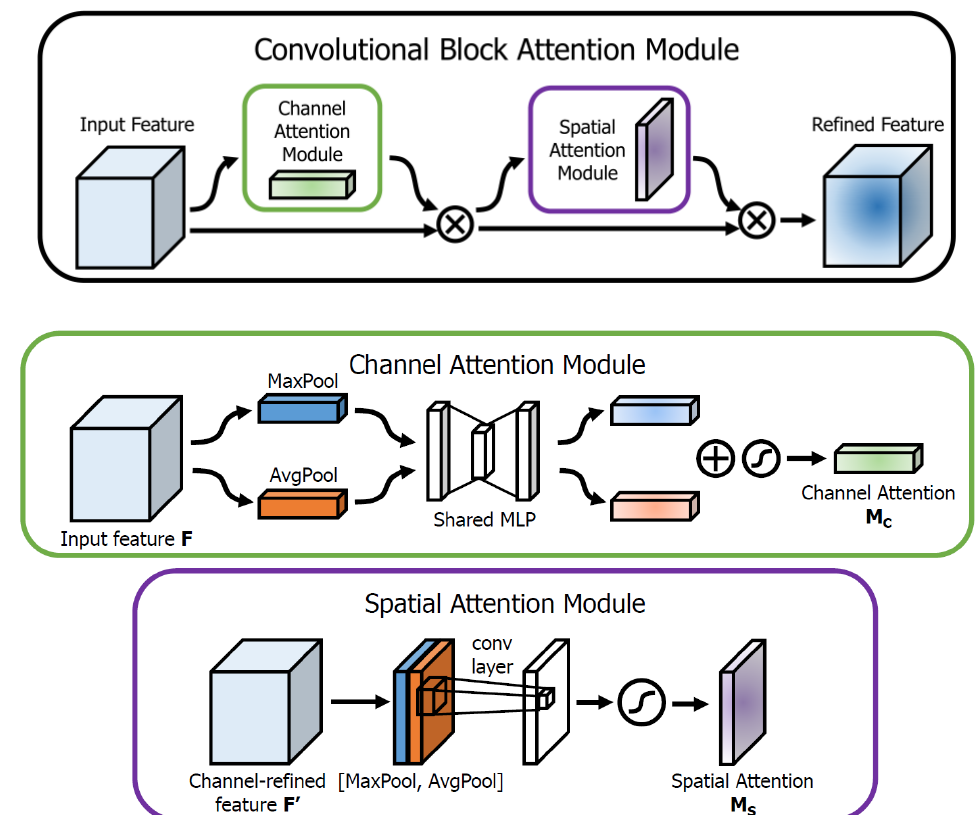
Figure 7. CBAM schematic diagram. The module has two sequential sub-modules: channel and spatial. the channel sub-module utilises both max-pooling outputs and average-pooling outputs with a shared network; the spatial sub-module utilises similar two outputs that are pooled along the channel axis and forward them.